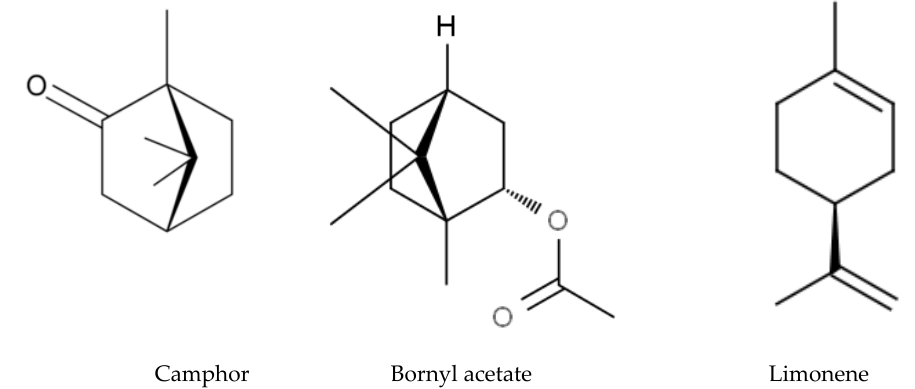
Figure 15. Monoterpens of Juniperus ashei.